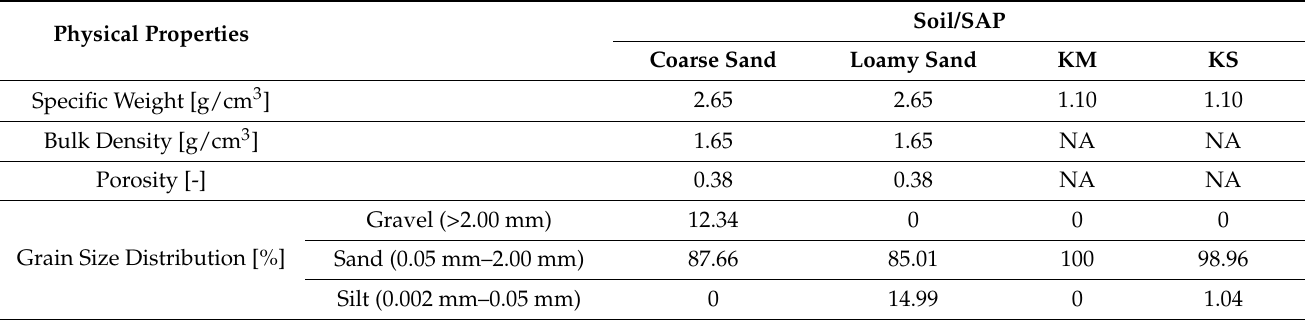
Figure 1. Schematic drawing of the test equipment, where: 1. Mariotte’s bottle; 2. Elastic tube; 3. Sealed top cover with an outflow tube; 4. Stainless steel cylinder with a watertight bottom; 5. SAP-soil mixture; 6. Porous pad; 7. Filtration mesh disc; 8. Plastic container; 9. Weighing scale machine. Table 1. Basic properties of the soils and SAPs used for